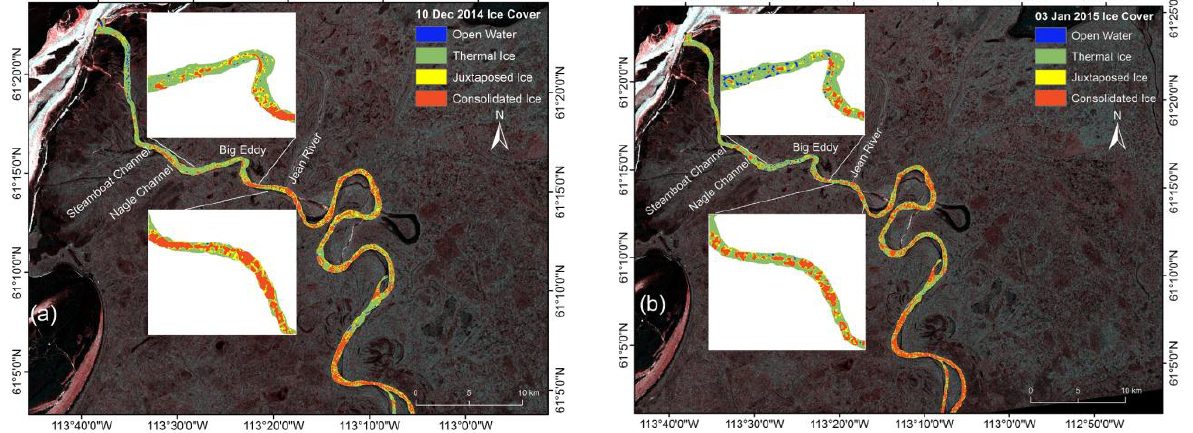
Figure 17. Ice cover during winter 2014–2015, from RADARSAT-2 images acquired on 10 December 2014 ( a ) and 3 January 2015 ( b ). (RADARSAT-2 Data and Products © MacDonald, Dettwiler and Associates Ltd. (2014–2015)—All Rights Reserved. RADARSAT is an official trademark of the Canadian Space